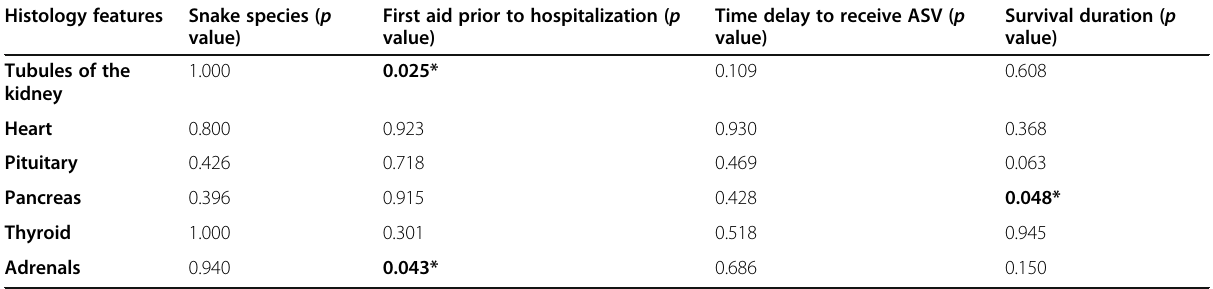
Table 5 Association between the epidemiological factors (snake species, first aid prior to hospitalization, time delay to receive ASV, and survival duration) and histological features of study samples (kidney, heart, and endocrine glands) Histology